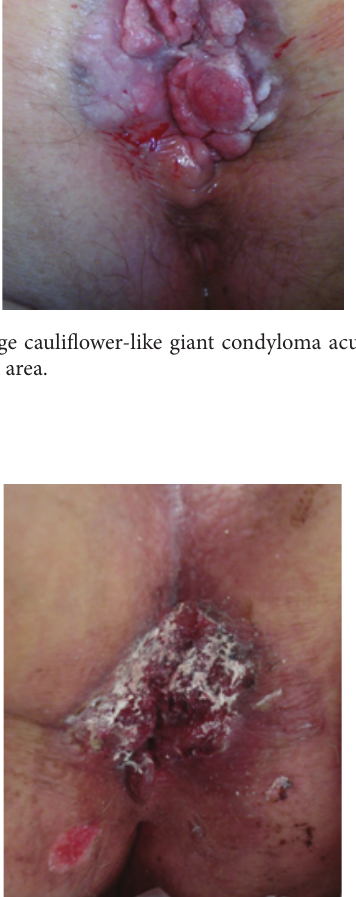
dysplasia of the epithelium with koilocytosis atypia, acan-